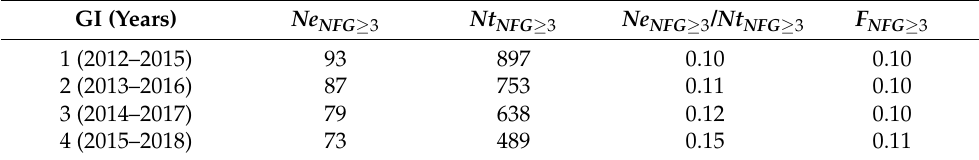
Table 8. Estimated effective population size in recent populations (animals with NFG >